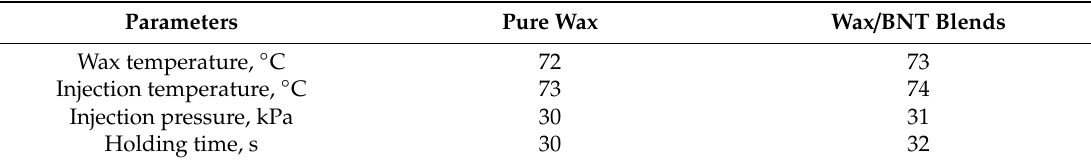
Table 4. The injection process parameters of pure wax and wax/BNT blends.